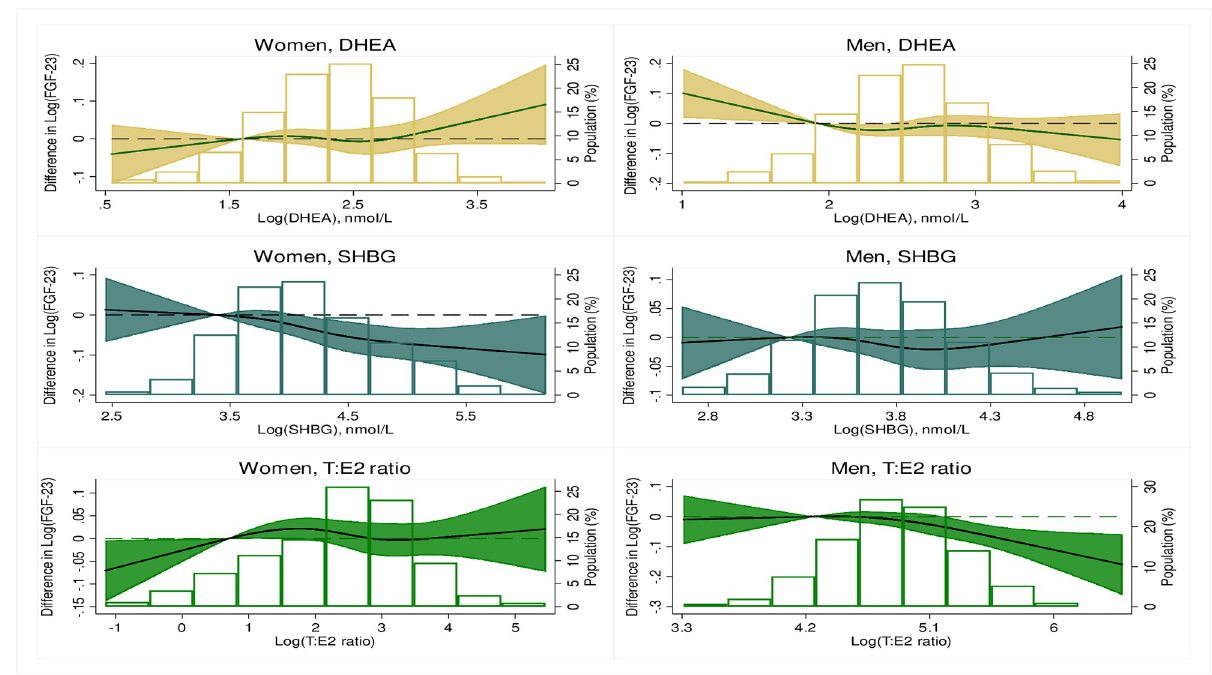
Fig 3. Restricted cubic splines of the associations between logarithmically transformed sex hormones (DHEA, SHBG and T/E2 ratio) and FGF- 23. [The model was adjusted for demographic variables, CVD risk factors and related mineral metabolites of 25-hydroxyvitamin D, calcium, phosphorus and parathyroid hormone (In women, the model was additionally adjusted for years since menopause and current use of hormone therapy)]. Difference in logarithmically transformed FGF-23 and proportion of the population are on the y-axis while logarithmically transformed sex hormones are on the x-axis. Abbreviations : DHEA, dehydroepiandrosterone; SHBG, sex hormone binding globulin; T: E2 ratio, Testosterone: Estradiol ratio.